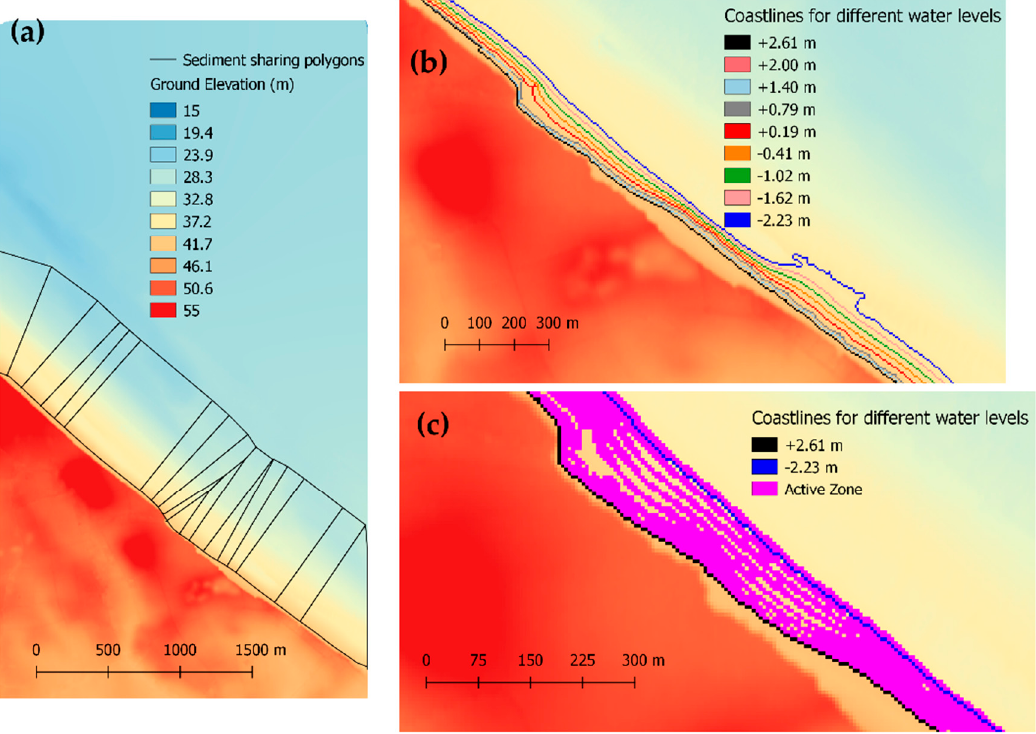
Figure 14. Details of key modelling features over the full tidal range for the simulated year 1999; ( a ) shows the sediment sharing polygons that are automatically delineated at every time step. This figure shows the polygons for the shoreline delineated at the maximum water level (WL = +2.61 m); ( b ) delineated shoreline location at different water levels; ( c ) cells marked as active zones for all water levels shown in panel b. The shorelines for maximum and minimum water level are indicated for reference.